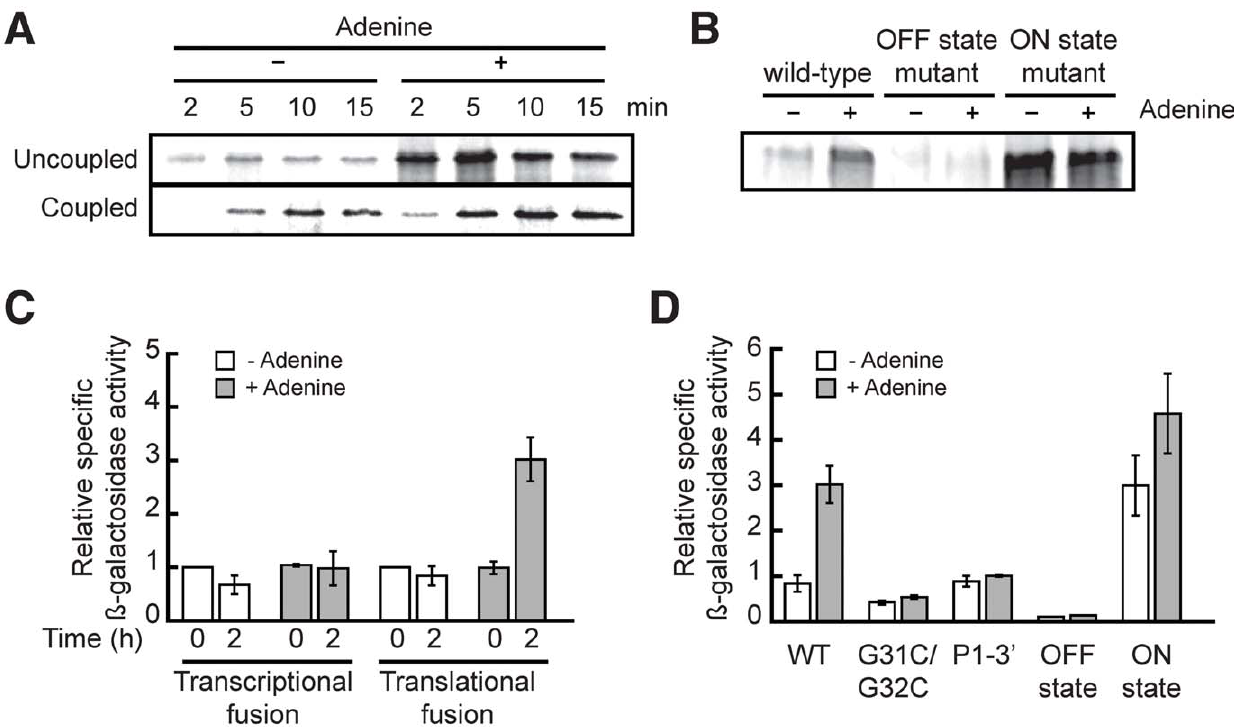
Figure 3. The add riboswitch positively regulates gene expression invitro and invivo . (A) In vitro translation assays of the add riboswitch using pre-transcribed mRNA (uncoupled) or DNA (coupled) as template. (B) In vitro translation assays of different mutations of the add riboswitch using pre-transcribed mRNA as template. (C) In vivo b -galactosidase assays with transcriptional and translational fusions of the add riboswitch to the lacZ gene. (D) In vivo b -galactosidase assays with mutants of the add’-’lacZ translational fusion. In all b -galactosidase assays, adenine was added at an OD 600 of 0.3 (time=0) to a final concentration of 500 m M.